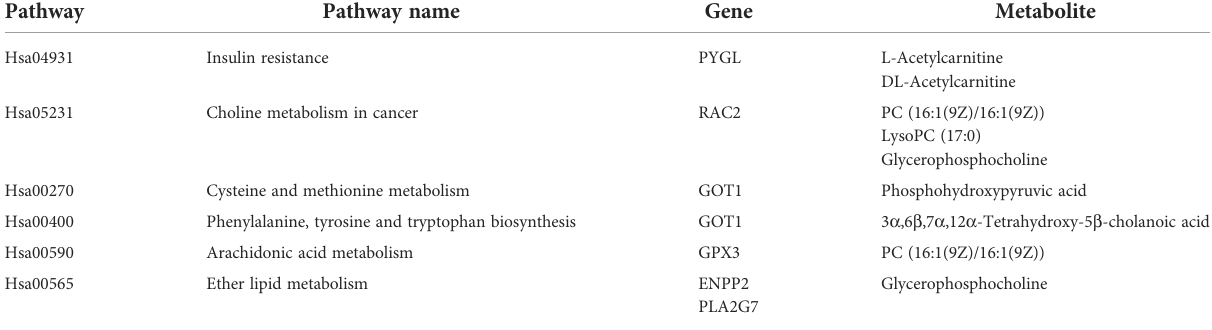
TABLE 3 Six pathways showing the differential proteins and metabolites involved.